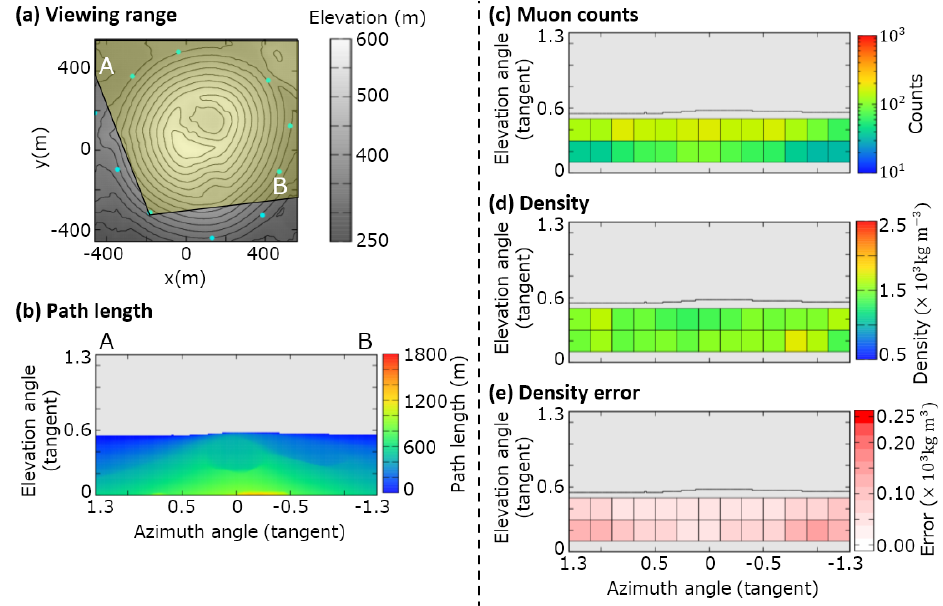
Figure B4. Observation site SW. (a) Map, topography, and viewing range; (b) path length of the volcanic cone; (c) muon counts N obs (d) density ρ i . The maximum value of the color bar indicates a density of > 2 . 5 × 10 3 kgm − 3 and the minimum value is < 0 . 5 × 10 3 kgm − 3 . (cid:16) (cid:17) − ρ low ρ up / 2. The maximum value of the color bar indicates a density error of > 0 . 25 × 10 3 kgm − 3 . (e) Density error (cid:49)ρ = i i